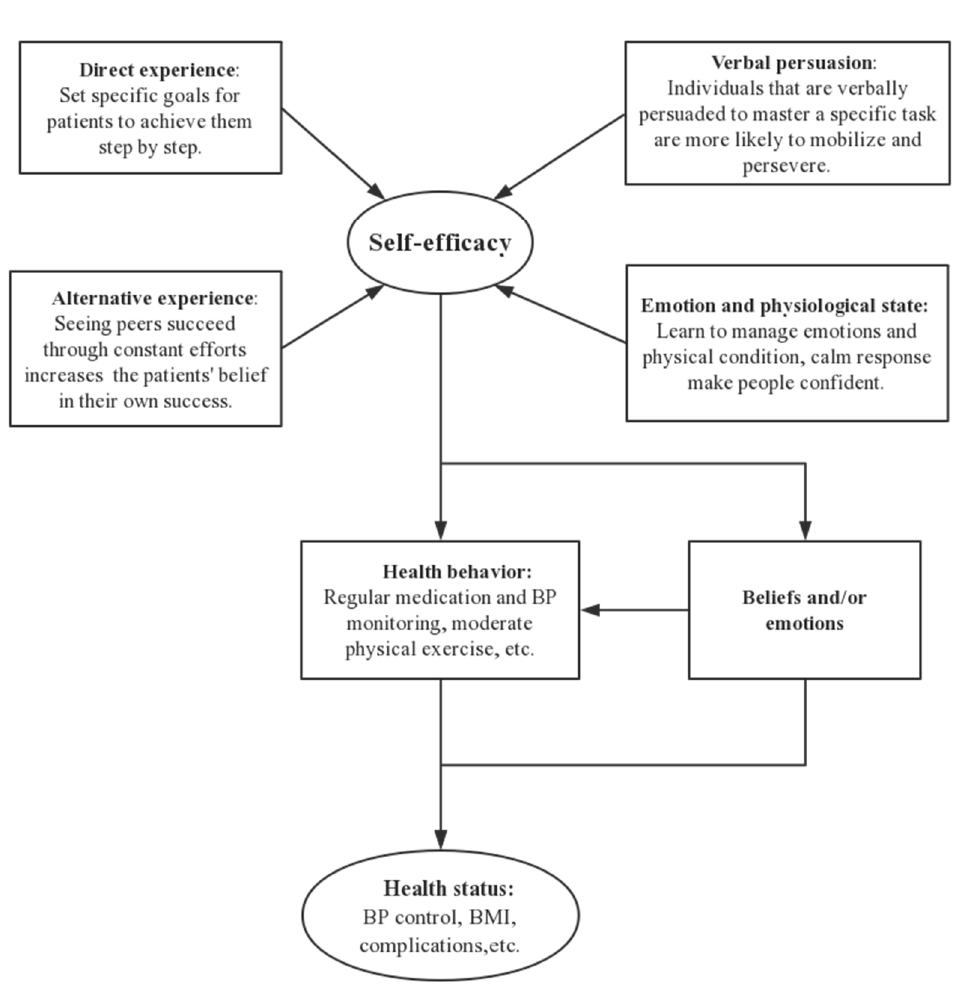
Figure 1. The framework of self-efficacy in this study. BP: blood pressure.